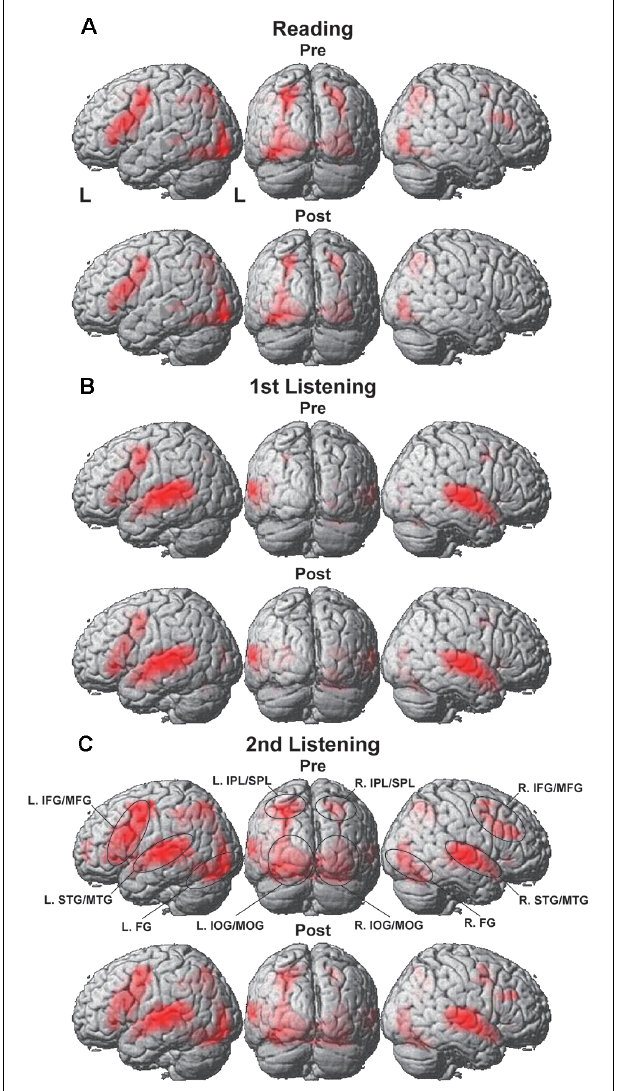
FIGURE 3 | Overall cortical activation during the presentation of the Pre or Post sets. (A) Reading events, (B) first listening events, and (C) second listening events. Activations were projected onto the left (L) lateral, back, and right lateral surfaces of a standard brain (thresholded at uncorrected p < 0.0001 for the voxel level, and at corrected p < 0.05 for the cluster level). Regions of interest (ROIs) are denoted with black ellipses. Visual and audio areas were activated bilaterally, while the language-related frontal activations were left-dominant. IFG/MFG, the inferior and middle frontal gyri; STG/MTG, the superior and middle temporal gyri; IPL/SPL, the inferior and superior parietal lobules; FG, the fusiform gyrus; and IOG/MOG, the inferior and middle occipital